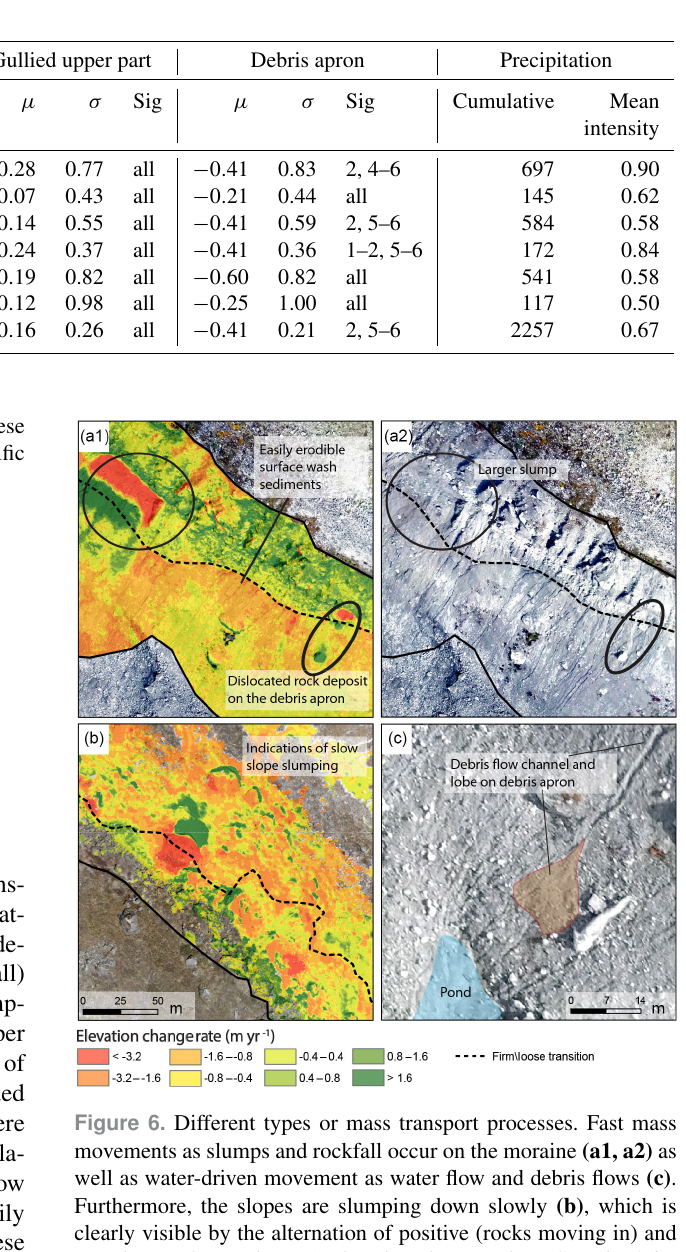
Table 3. Seasonal elevation change values, furthermore divided into upper and lower moraine. The zonal mean ( µ ) is reported, as well as the 1 σ standard deviation ( σ ). Precipitation is measured at Kyanjing station in 2013 and Langshisha station in all others seasons. Elevation change values are in myear − 1 , precipitation values in mm and mmh − 1 . The significance column (sig) indicates the periods from which that specific dataset statistically differs ( p < 0 . 05).